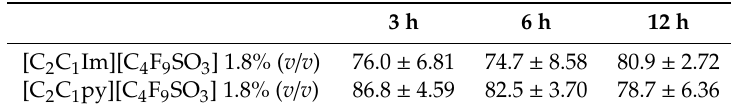
Mean values calculated from two independent assays and their standard